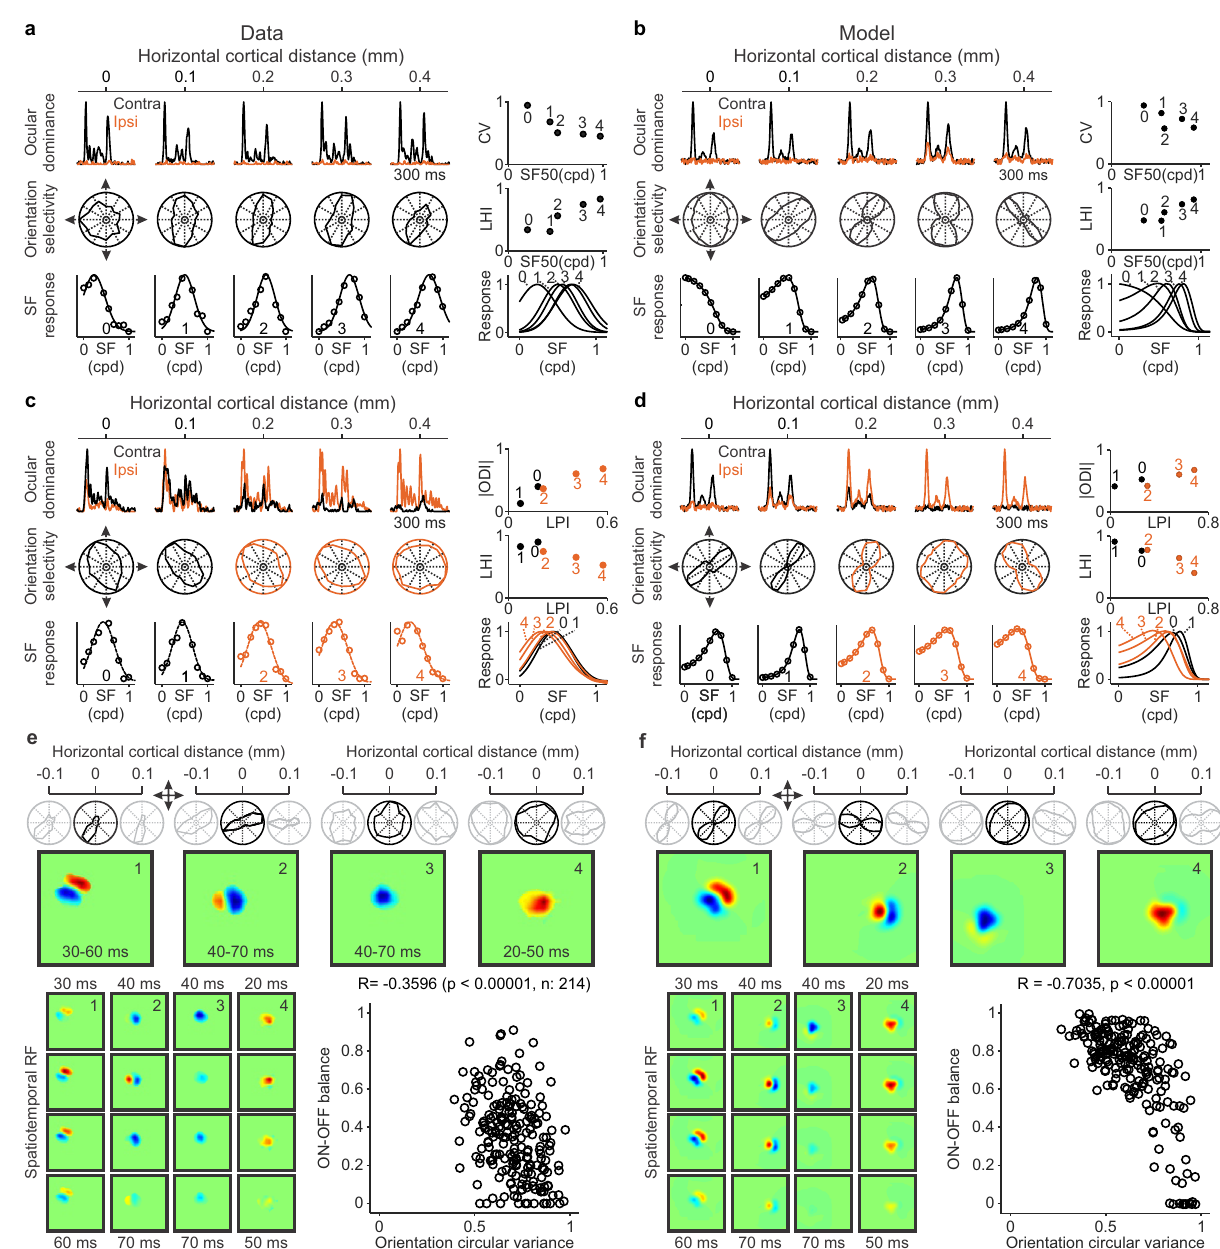
Fig. 8 Measurements of multiple stimulus dimensions along horizontal tracks of cat visual cortex and model simulations. a Example recording from a horizontal track parallel to an ocular dominance band. From top to bottom, the left panel shows responses to static gratings presented through the contralateral (black) or ipsilateral eyes (orange), orientation tuning, and spatial frequency tuning. The spatial resolution (highest spatial frequency generating half-maximum response, SF50) increases from cortical site 0 to 4, and this increase is associated with a decrease in orientation selectivity measured as circular variance (CV, right top) and an increase in orientation clustering (right middle) measured as a local homogeneity index (LHI). The right bottom panel shows the fi ve spatial frequency curves from the left panel superimposed to facilitate their comparison. b The model replicates the data illustrated in ( a ). c Example recording from a horizontal track crossing an ocular dominance border (same organization as in a ). The response strength to low spatial frequencies (LPI: low pass index) increases from cortical sites 0 to 4, and this LPI increase is associated with an increase in ocular dominance (right top, ODI: ocular dominance index) and a decrease in LHI (right middle). d The model replicates the data illustrated in c . e Top. Orientation tuning of four cortical sites (black) and their adjacent sites 100-microns apart (gray). Middle. Receptive fi elds with greater ON-OFF response balance (left) have higher orientation selectivity and local homogeneity index than those that are ON or OFF dominated (right). Bottom left. Receptive fi elds shown at different time delays from the stimulus. Bottom right. Signi fi cant correlation between orientation selectivity and ON-OFF balance (rank correlation with Matlab ‘ corr ’ function, R: correlation coef fi cient, p: probability of no correlation). f The model replicates the experimental measures in e . Source data are provided as a Source Data fi